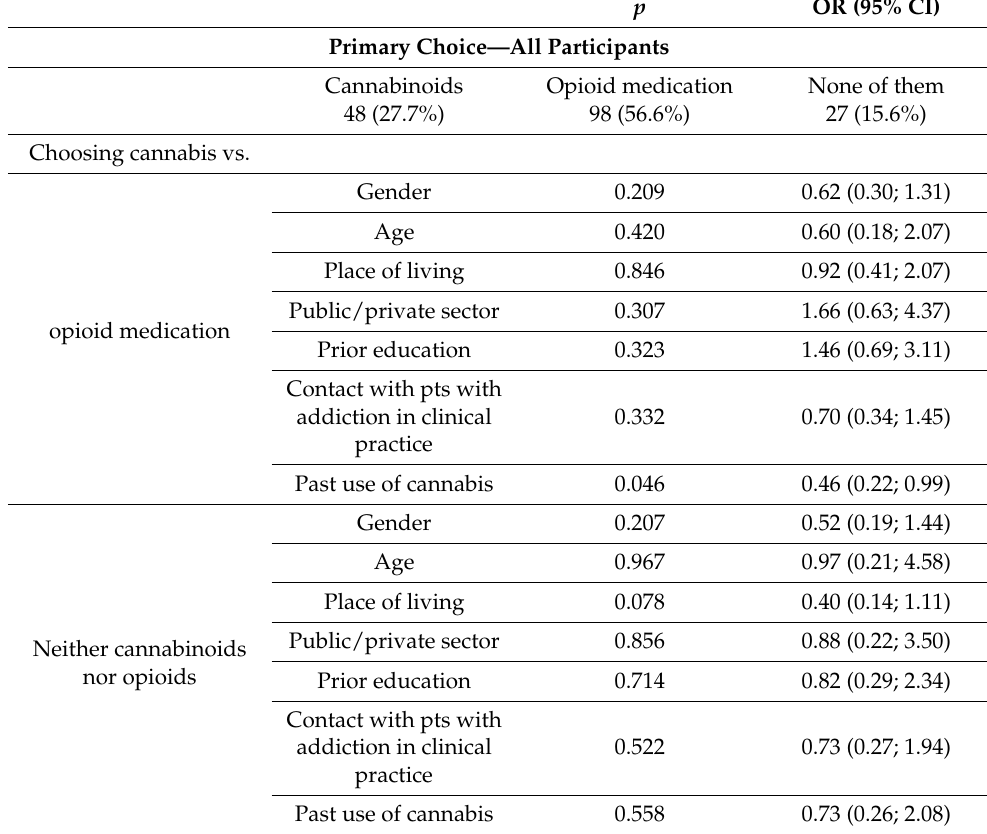
Table 7. Factors correlated with cannabinoids as the first-choice treatment for significant pain (for participants or their relatives) and the OR of using opioids/no medication in reference to cannabinoids. p OR (95% CI) Primary Choice—All Participants Cannabinoids Opioid medication None of them 48 (27.7%) 98 (56.6%) 27 (15.6%) Choosing cannabis